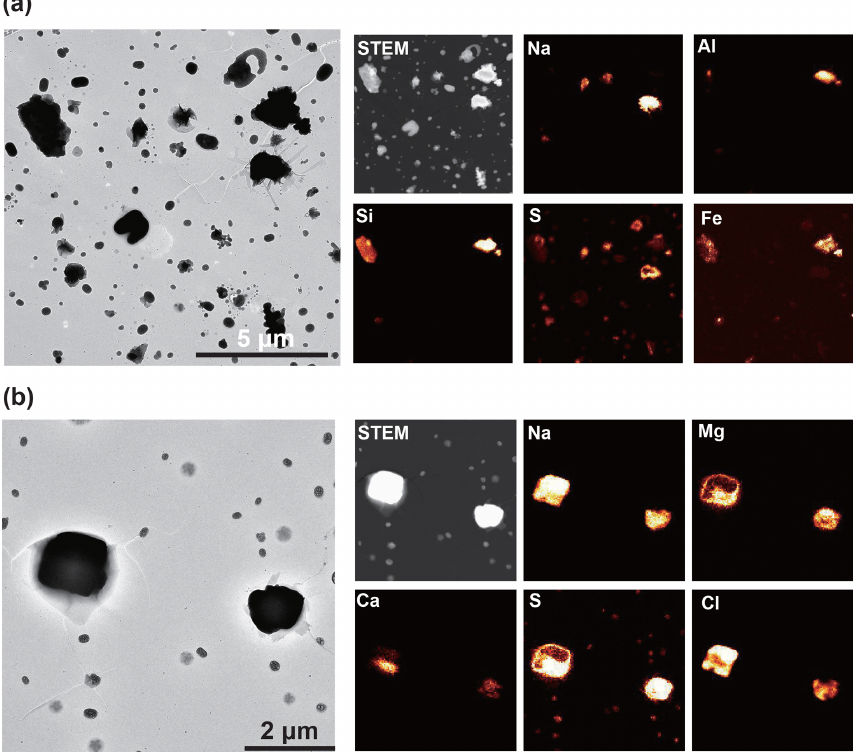
Figure 4. TEM (left) and elemental mapping images (right) of an ambient aerosol sample with a relatively high (a) mineral dust particle fraction (10%) and (b) sea salt particle fraction (52%). Samples (a) and (b) were collected on 13 July 2018 (19:30) and 30 August 2018 (18:51), respectively. Mineral dust particles mainly consist of Al, Si, and Fe. Sea salt particles mainly consist of Na and Cl, with Mg and S on their